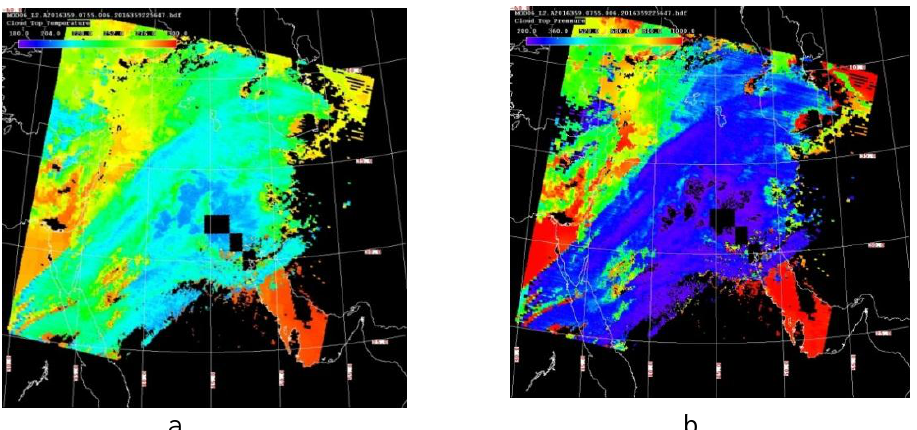
Fig. 12: a) Cloud top pressure in blue color over most of Iraq cities which is (200 – 360) hpa (hectopascal), b) represent clouds top temperature in light blue and cyan (180 – 228)